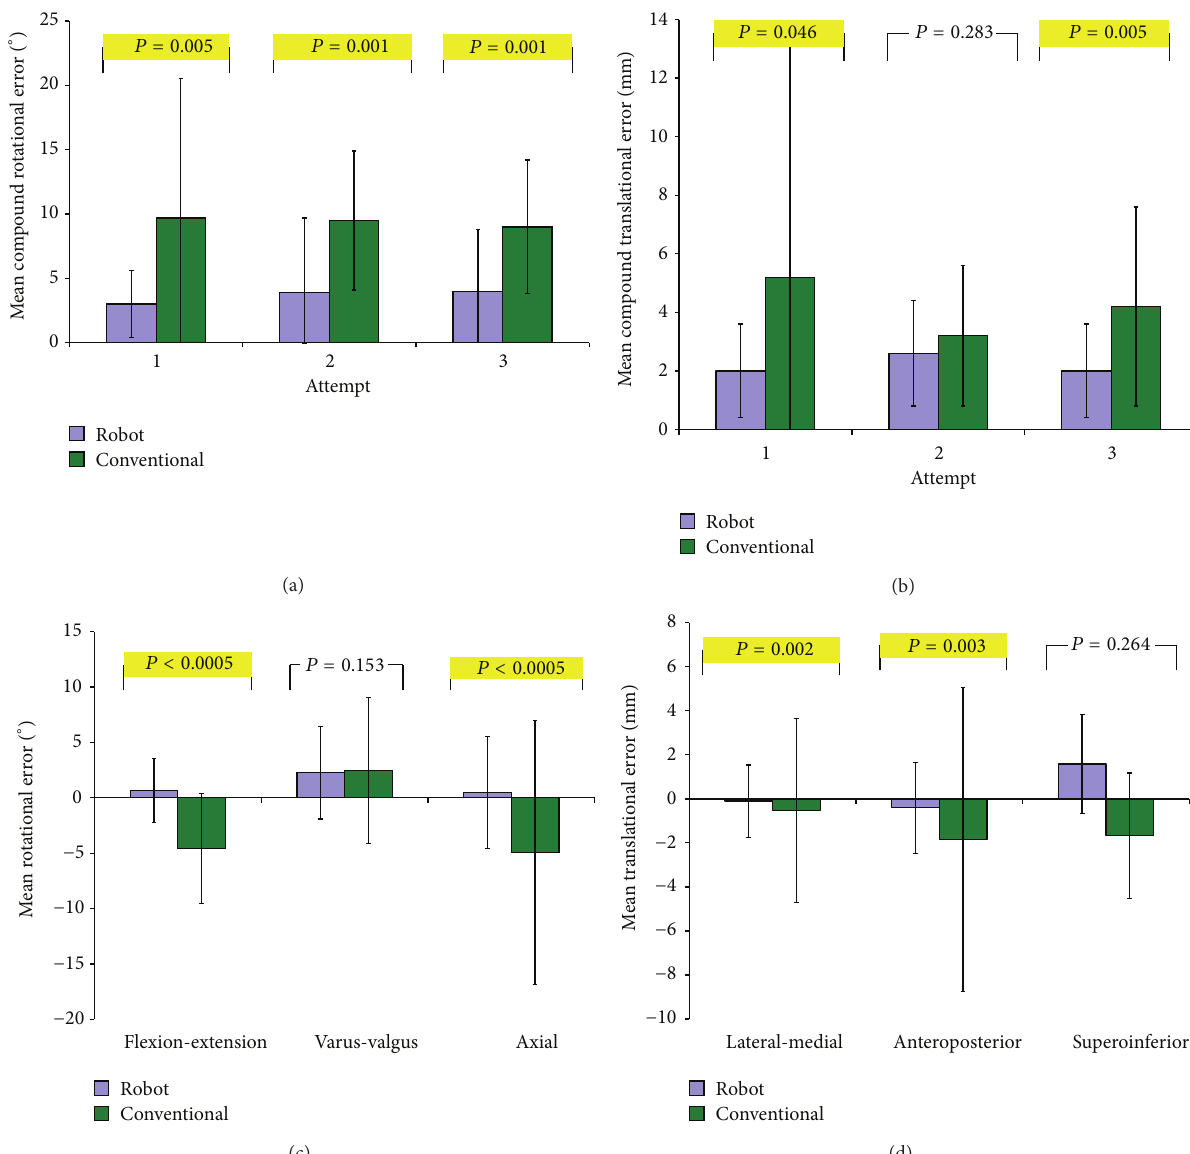
Figure 1: Bar graphs comparing tibial component positioning in robot and conventional groups at attempts 1, 2, and 3 by mean (a) compound rotational error, (b) compound translational error, (c) rotational alignment in each DoF, and (d) translational alignment in each DoF. 𝑃 values compare mean root mean squared errors between